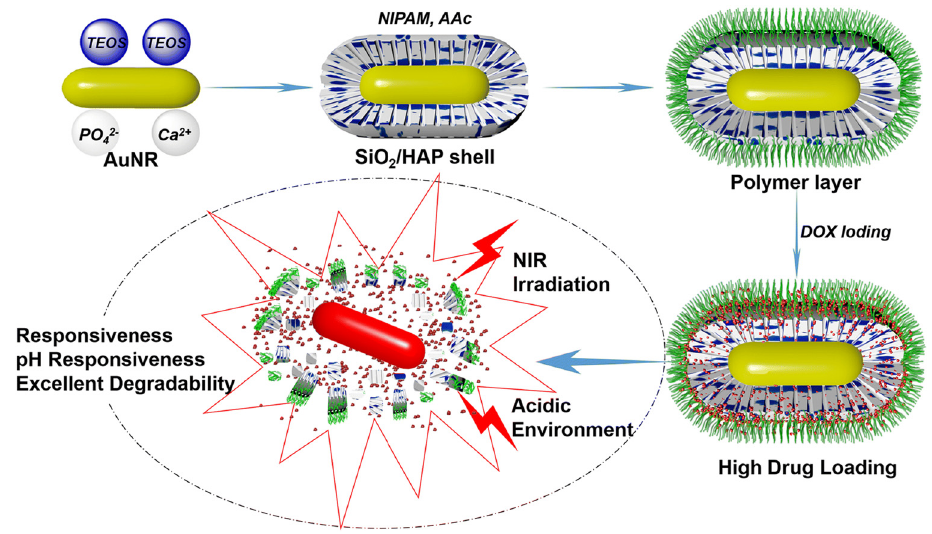
Figure 25: Preparation of AuNRs/SiO 2 /HAP/PNA nanoparticles [ 162 ] ; Copyright: 2019 with permission from Springer Nature.